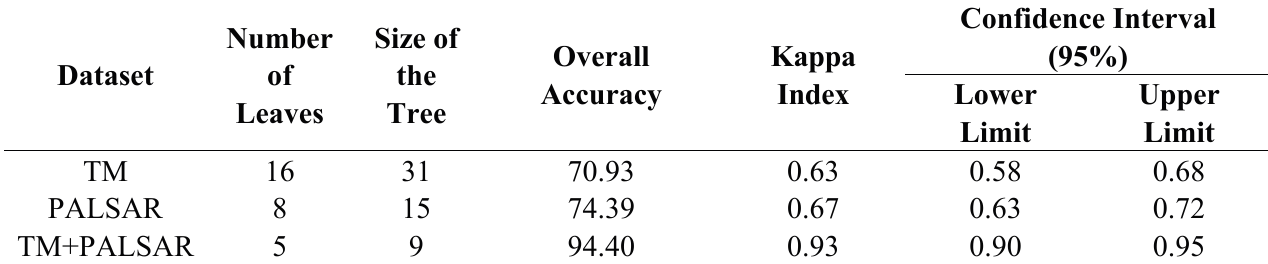
Table 2. Characteristics of the decision tree and validation of the remote sensing datasets.